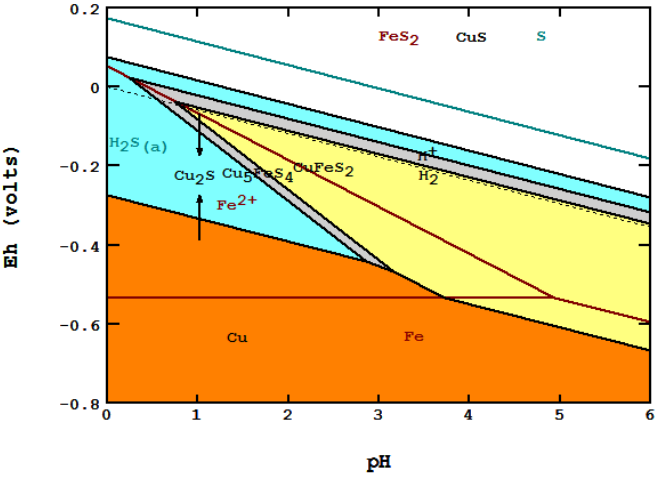
Figure 22. Combination of three Eh-pH diagrams showing the galvanic conversion reactions of chalcopyrite with metallic copper.